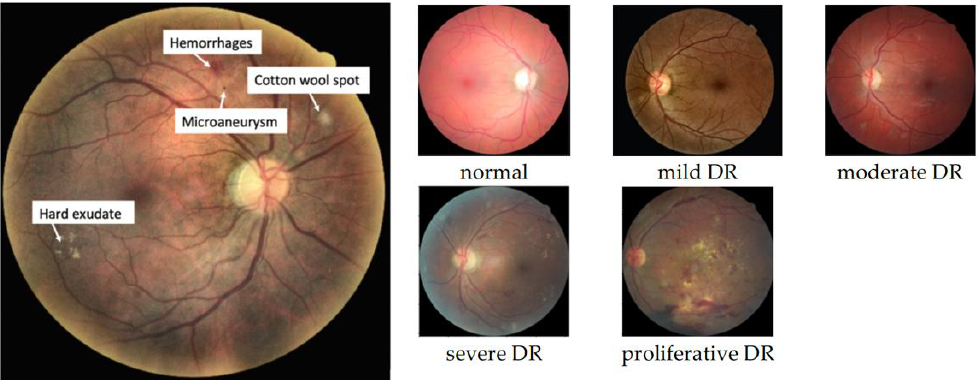
Figure 1. Different DR lesions ( left ) and DR stages ( right ).